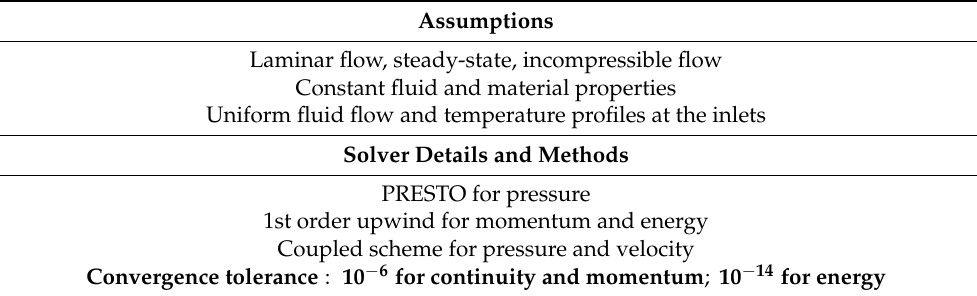
Table 6. Assumptions and solver